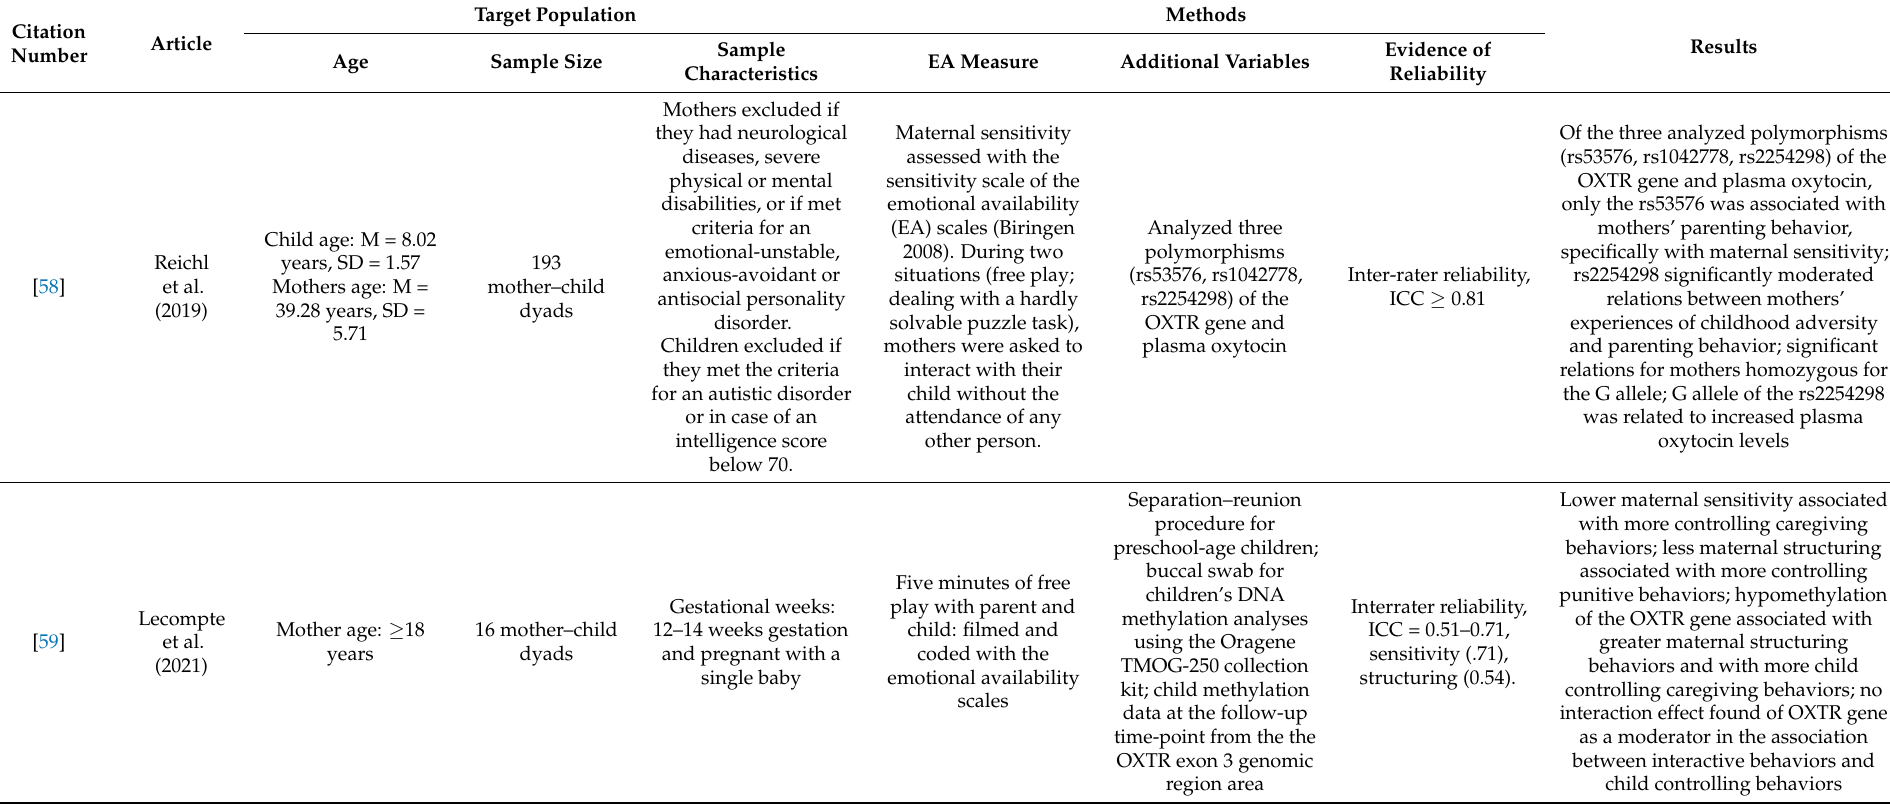
Table 2. Characteristics of the studies included in the review with a genetics and epigenetics